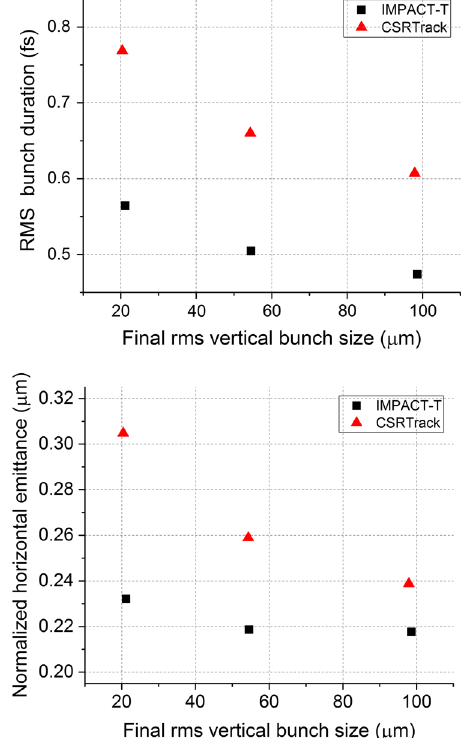
FIG. 7. Final bunch duration and normalized horizontal emit- tance simulated by IMPACT - T and CSRT rack for different beam optics. The bunch charge is 2.7 pC.